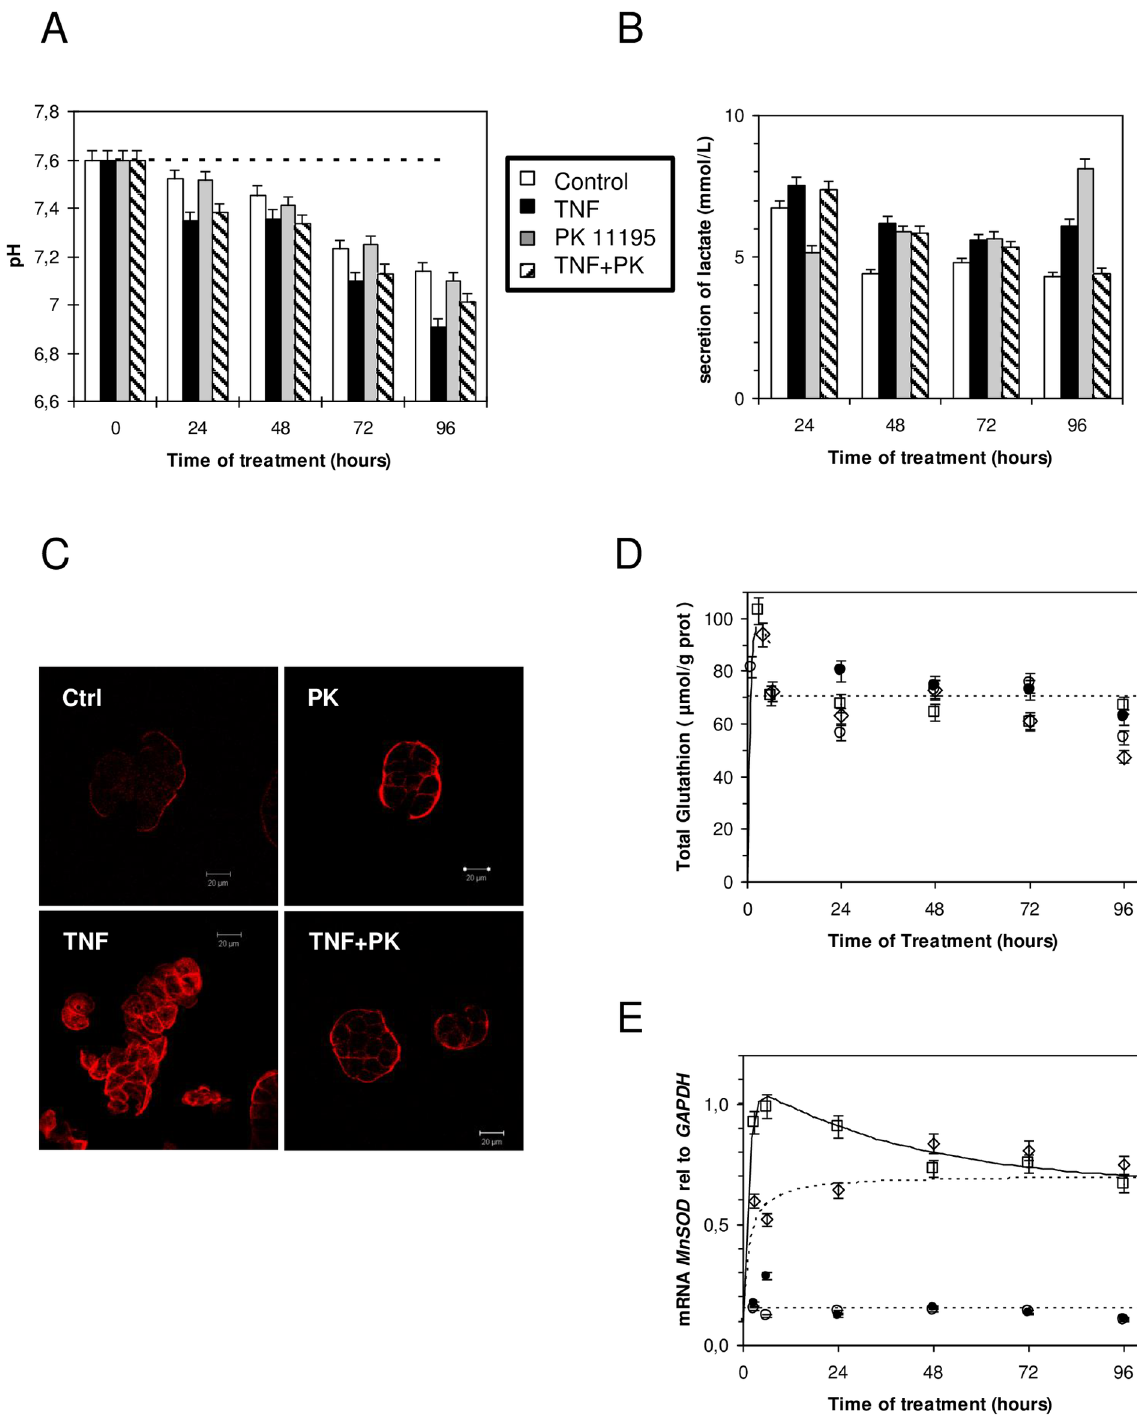
Fig 3. HT-29 cell metabolism upon TNF treatment. (A) Time course of cell culture medium pH change as a function of treatment (open bars, control; black bars, 10 ng/mL of TNF renewed daily; grey bars, 1 μ M of PK 11195 treatment; dashed bars, 10 ng/mL of TNF and 1 μ M of PK 11195, renewed daily). (B) Time-dependent lactate accumulation in cell culture medium; treatment as in panel A. (C) Actin stress fiber formation after 4 hours upon similar treatment as in panel A (control, upper left panel; 1 μ M of PK 11195-treated cells, upper right panel; 10 ng/mL of TNF-treated cells, lower left panel; 10 ng/mL of TNF and 1 μ M of PK 11195-treated cells, lower right panel). (D) Time-dependent total glutathione measurement; treatment as in panel A (closed circles, control; open squares, in the presence of 10 ng/mL of TNF daily replaced; grey triangles, 1 μ M of PK 11195 replaced daily; grey diamonds, in the presence of 10 ng/mL of